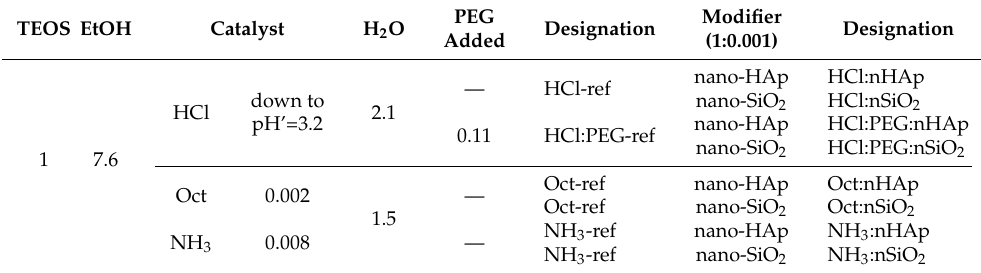
Table 1. Molar ratios of the several formulations prepared in the present work: TEOS:EtOH:Catalyst: H 2